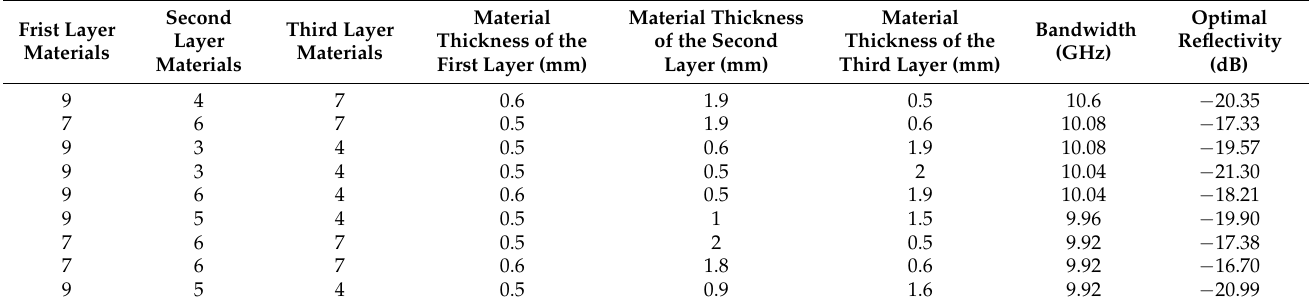
Table 8. The optimization results using objective function F2 (three-layers) of ABC algorithm. Frist Layer Materials